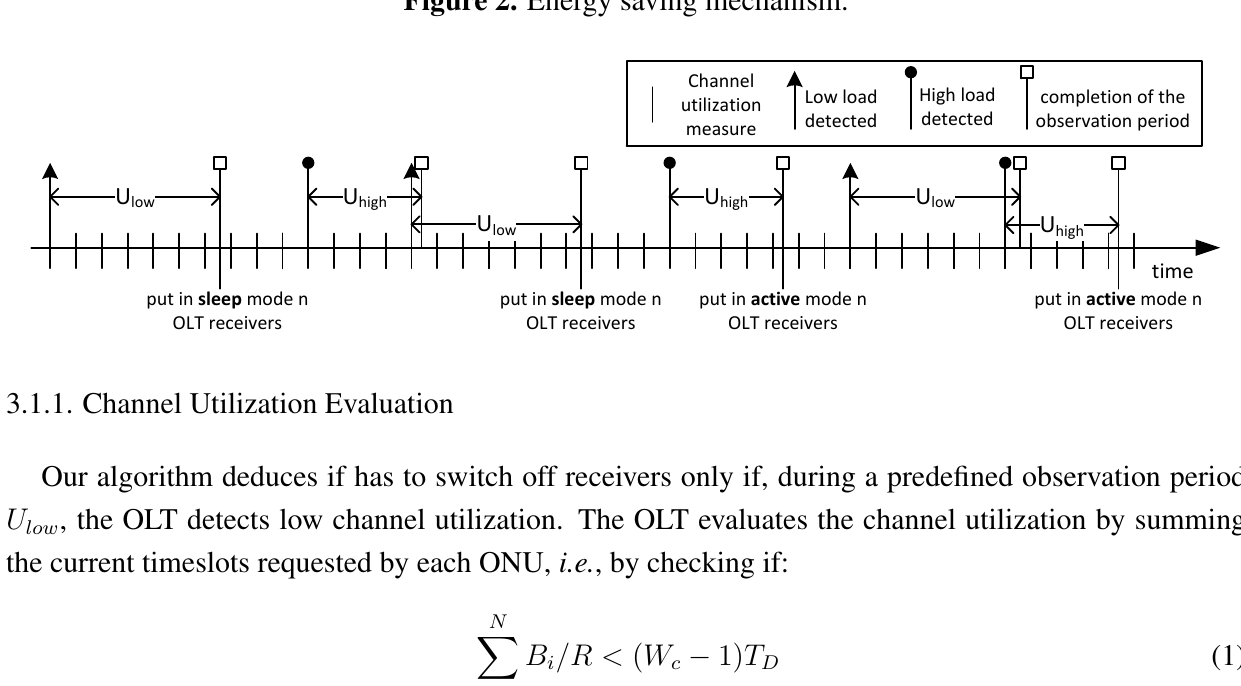
Figure 2. Energy saving